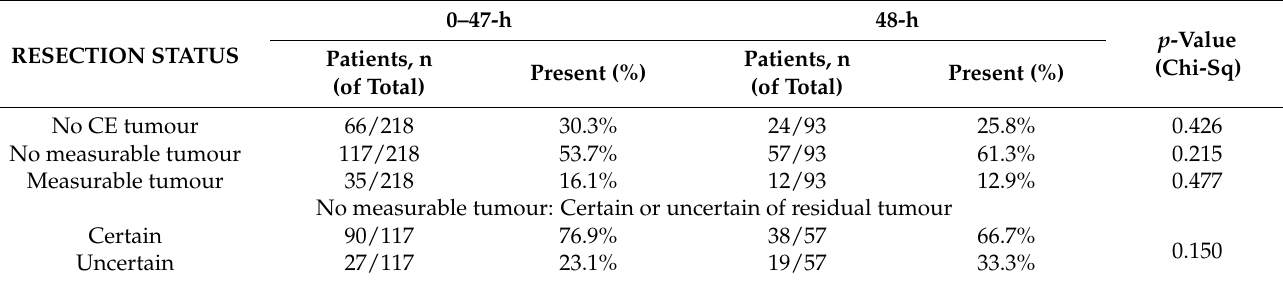
Table 2. The distribution of resection status before and after